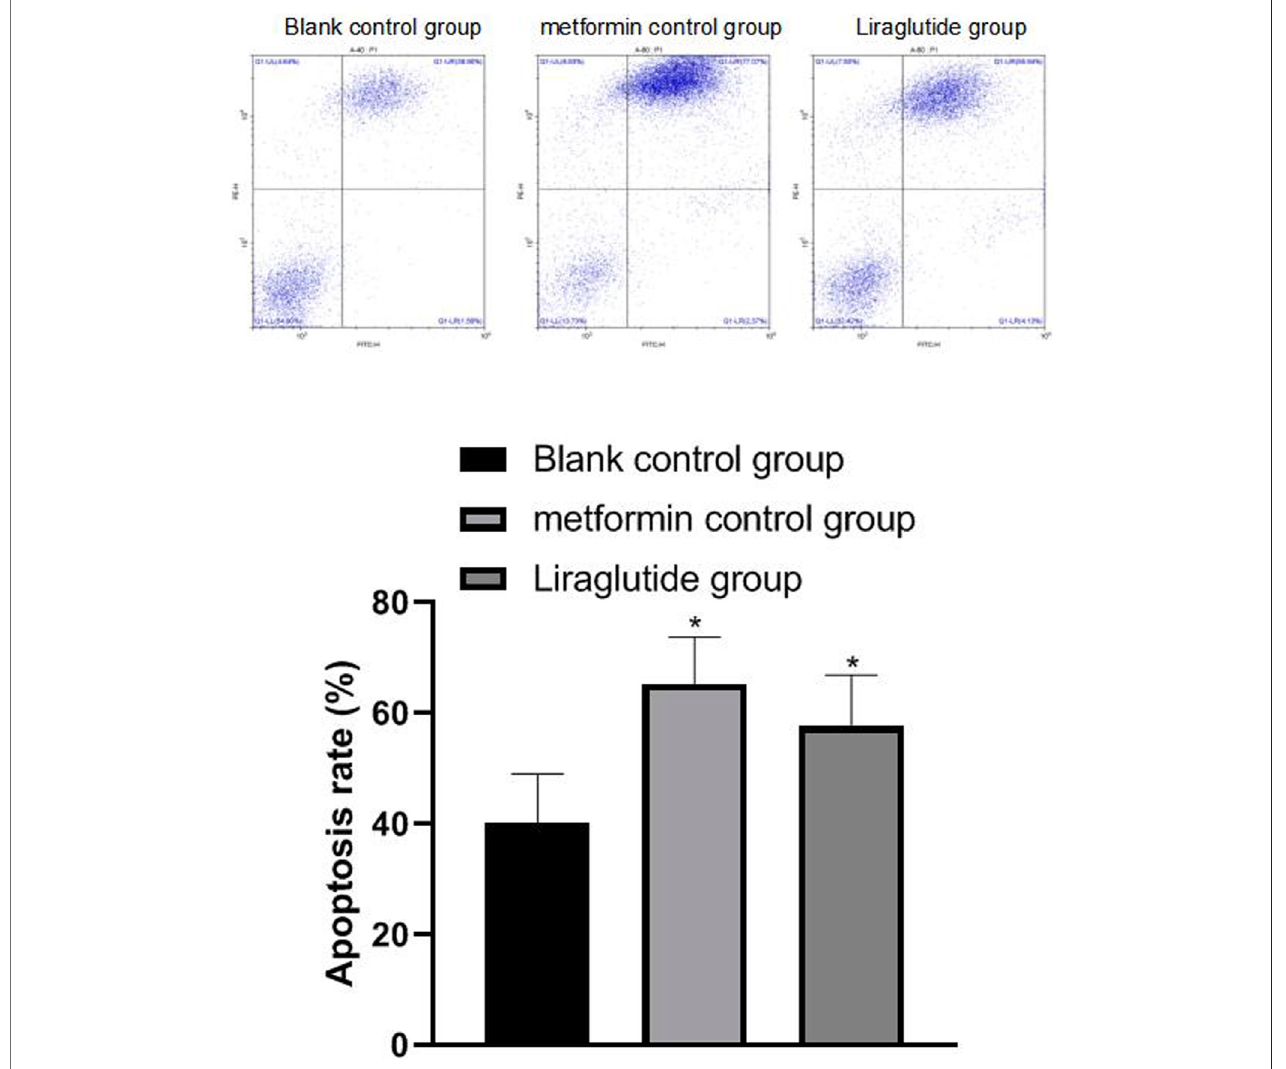
FIGURE 4 | Effects of GLP-1 receptor agonists on apoptosis of CRC cells. Note: fl ow cytometry experiment, compared with blank control group, * p < 0.05.